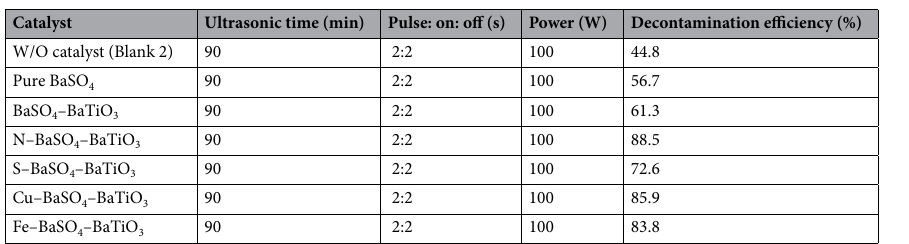
Table 2. Piezoelectric catalytic capability of Pure BaSO 4 , BaSO 4 –BaTiO 3 , Cu–BaSO 4 –BaTiO 3 , Fe–BaSO 4 – BaTiO 3 , S–BaSO 4 –BaTiO 3 , N–BaSO 4 –BaTiO 3 nanostructure for degradation of